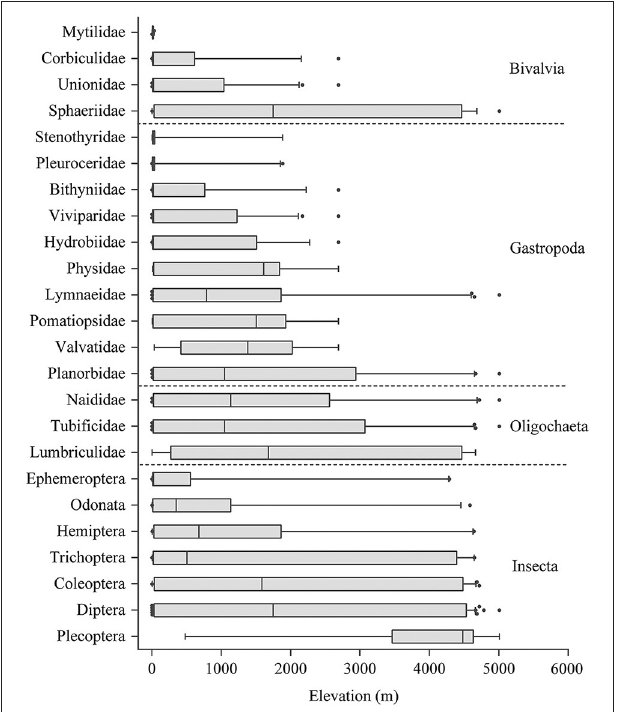
FIGURE 3 | Distributions of different groups of benthic macroinvertebrates along elevational gradient in lakes of China and